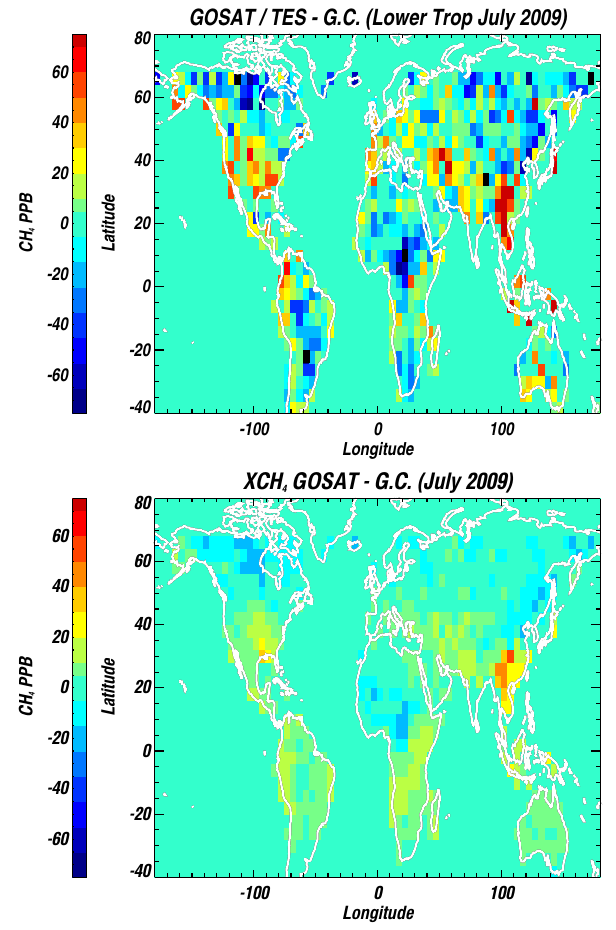
Figure 7. Top: difference in lower-tropospheric estimate between GOSAT/TES and the GEOS-Chem model. Black indicates no data. Bottom: difference in total column estimate between GOSAT and the GEOS-Chem